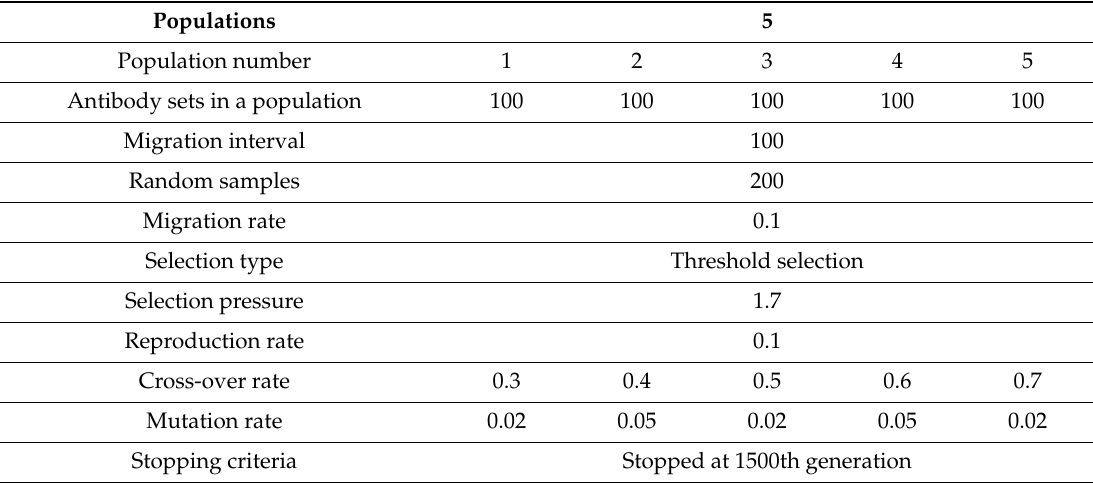
Table 6. Parameter setting in the IGA